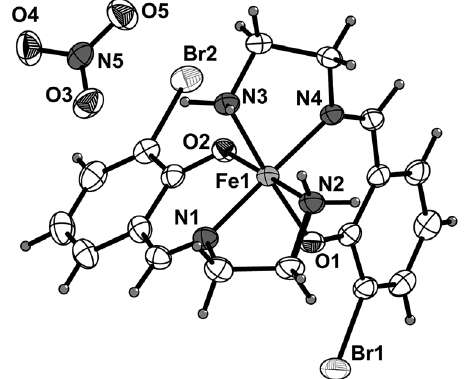
Table  : Data collection and